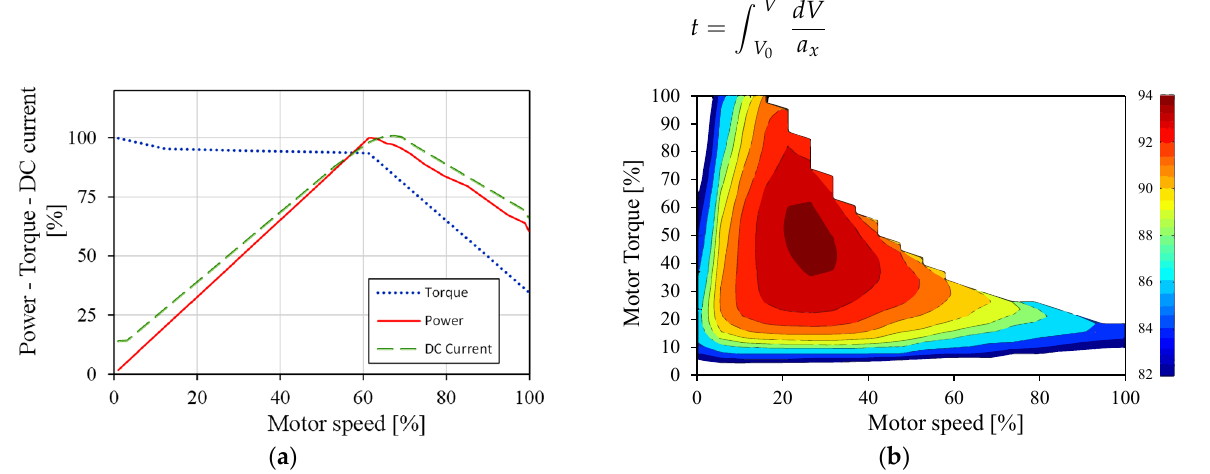
Figure 6. Typical AC electric motor ( a ) performance and ( b ) efficiency as a function of the motor rotating speed. Source : authors’ elaboration based on HPEVS AC motors [55,56].